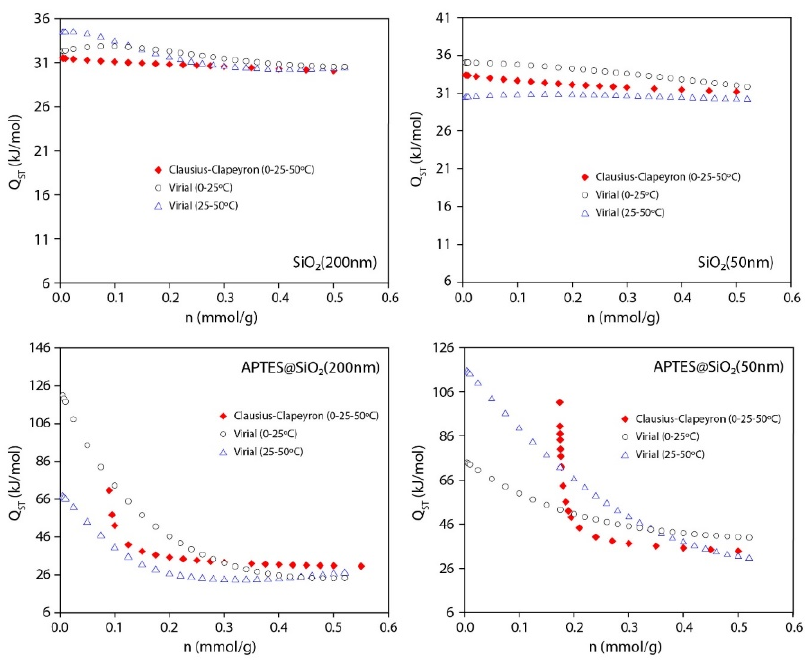
Figure 11. Heat of adsorption from Clausius-Clapeyron (red) using the isotherms at the three temperatures and from Virial equation fitting simultaneously the isotherms at 0 and 25 °C (black) and at 25 and 50 °C (blue).